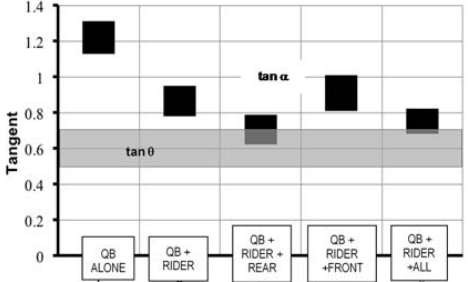
Figure 1. Static rear longitudinal instability angles (shown as tan α ) for the eight work Quad Bikes (QBs) and a range of typical traction coefficients (tan θ for tyres on agricultural soils.